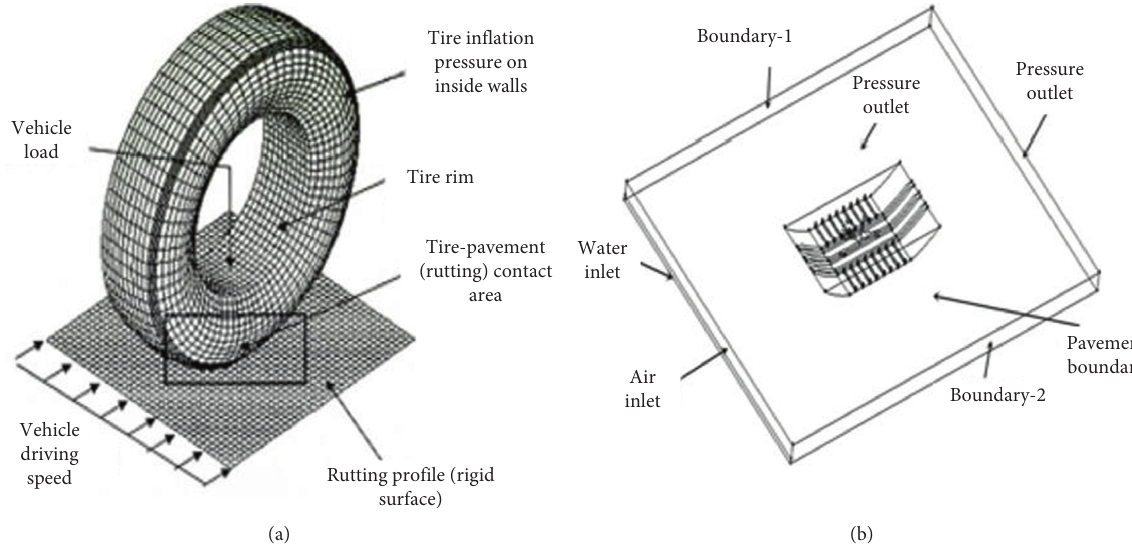
Figure 6: The 3D tire-road finite element model and the setting of model boundary conditions. (a) Tire hydroplaning FEM. (b) Fluid model.